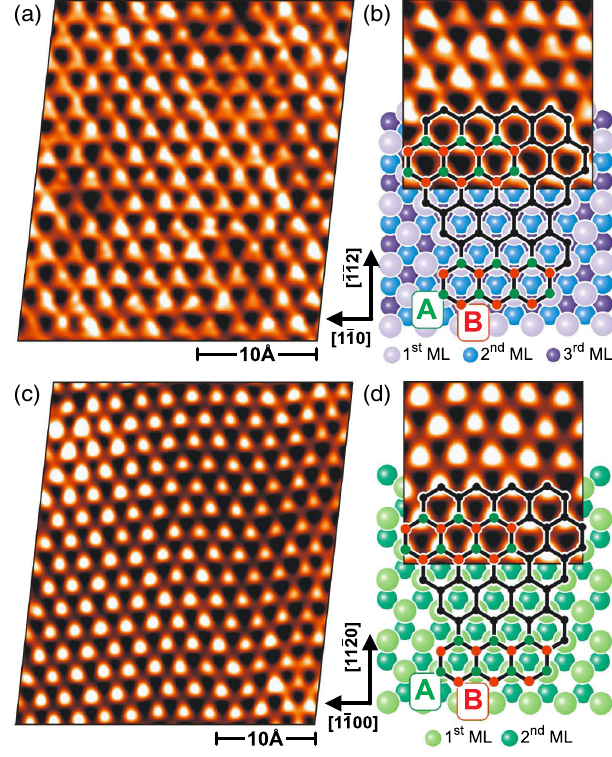
FIG. 1. STM evidence for the sublattice symmetry breaking of graphene (a),(b) on Ni(111) and (c),(d) on Co(0001). STM images in (a) and (c) show pronounced threefold symmetry. (b),(d) display structural models of graphene on Ni and Co, respectively, superimposed on the STM data. A - B sublattice symmetry breaks due to AC stacking, causing different environ- ments for A and B sublattices of graphene (green and red nodes, respectively). Tunneling parameters: V t ¼ þ 2 mV , I t ¼ 25 nA